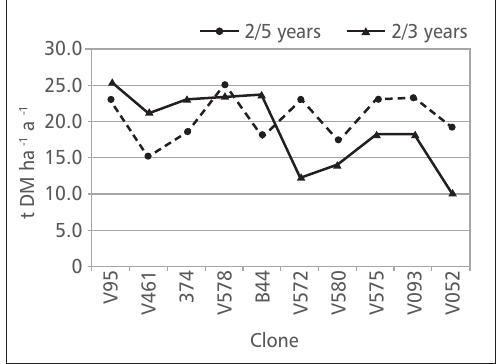
FIGuRE 1. Biomass production of the studied willow clones in Valpovo test in two successive rotations period (2/3 and 2/5